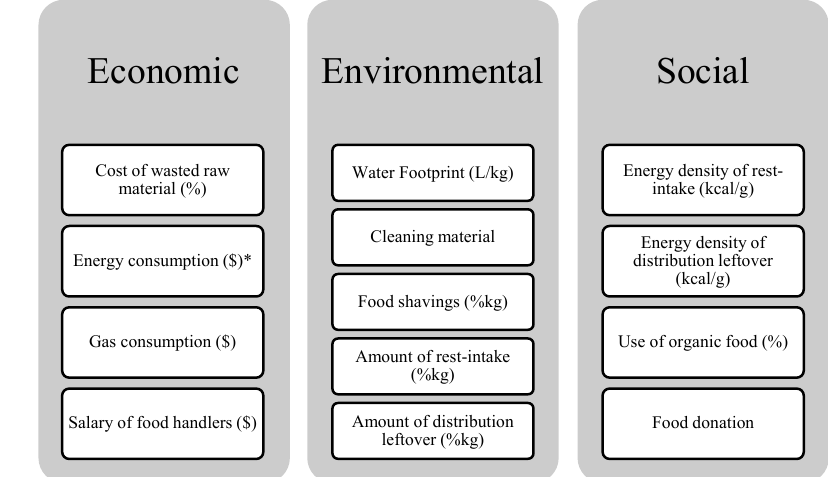
Figure 2. Aspects included and evaluated in each dimension (environmental, social, and economic) of the food waste impact. (*, This item considers all forms of energy consumption of the food service evaluated. This item will be divided later, depending on the food service. In the case of exclusive use of electricity, only one item should be considered; in food services that use electricity and liquefied petroleum gas, for example, this item will be stratified into two parts (as used in this study).